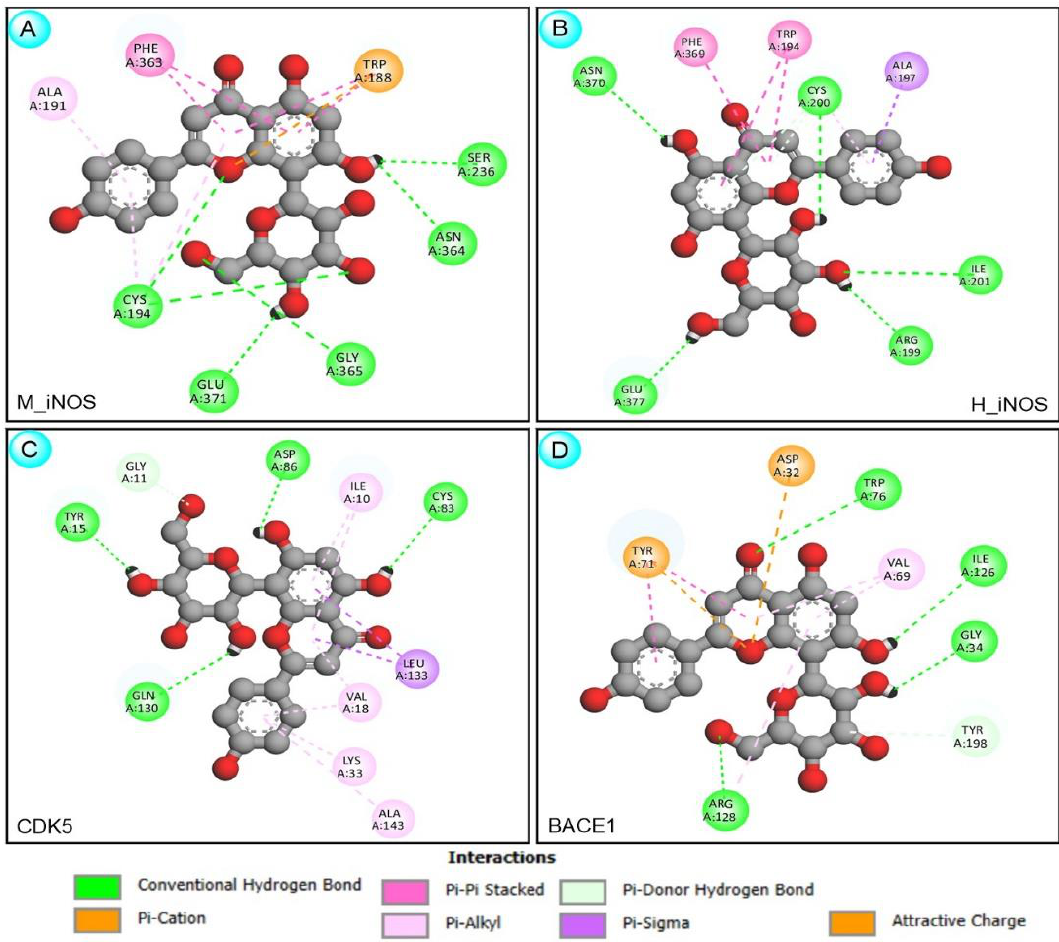
Figure 4. Visualization of protein – ligand interactions using BIOVIA-DSV software; ( A ): protein – ligand interactions between M_iNOS and ligand_ 3 ( − 11.4 kcal/mol); ( B ): protein–ligand interactions between H_iNOS and ligand_ 3 ( − 10.9 kcal/mol); ( C ): protein–ligand interactions between CDK5 and ligand_ 3 ( − 10.4 kcal/mol) and ( D ): protein–ligand interactions between BACE1 and ligand_ 3 ( − 10.1 kcal/mol). Ligand_ 3 : apigenin-8-C- β